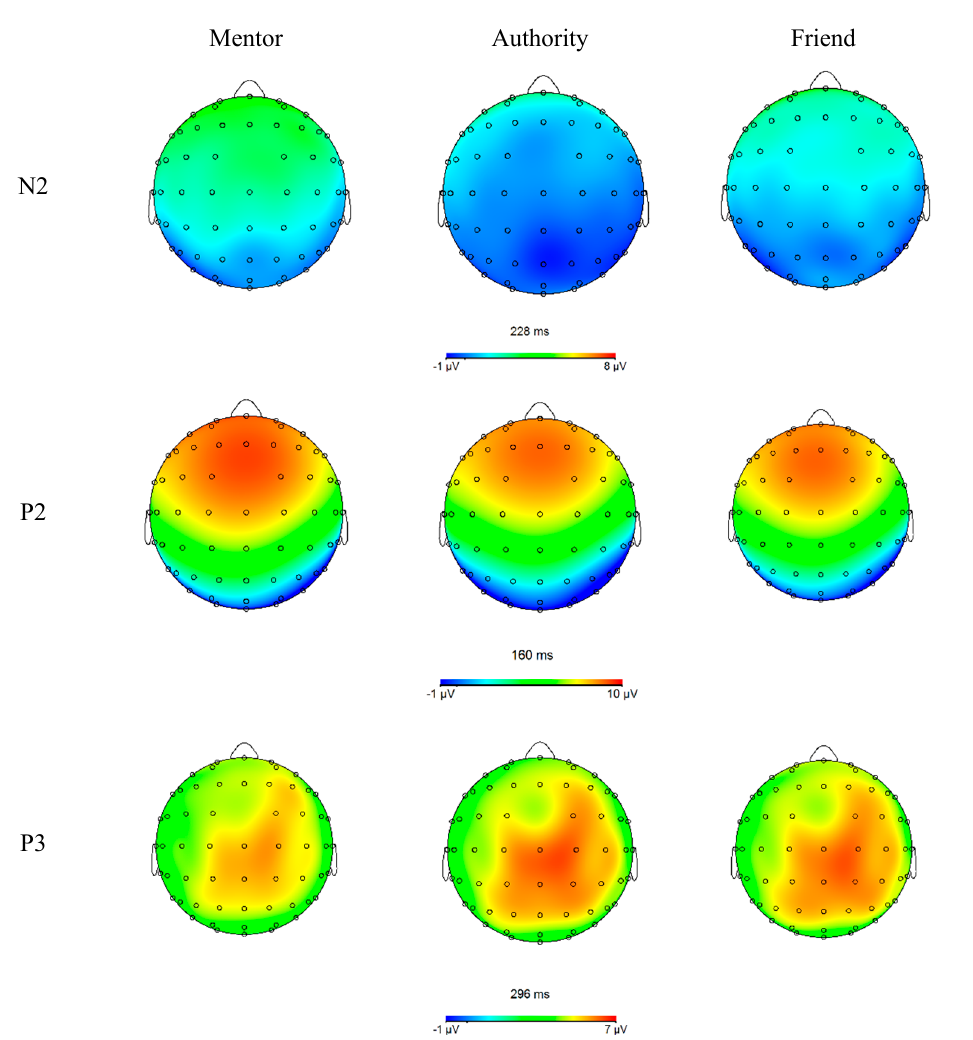
Figure 2. Grand average ERPs of the P2, N2 and P3 components at the indicated electrode sites.